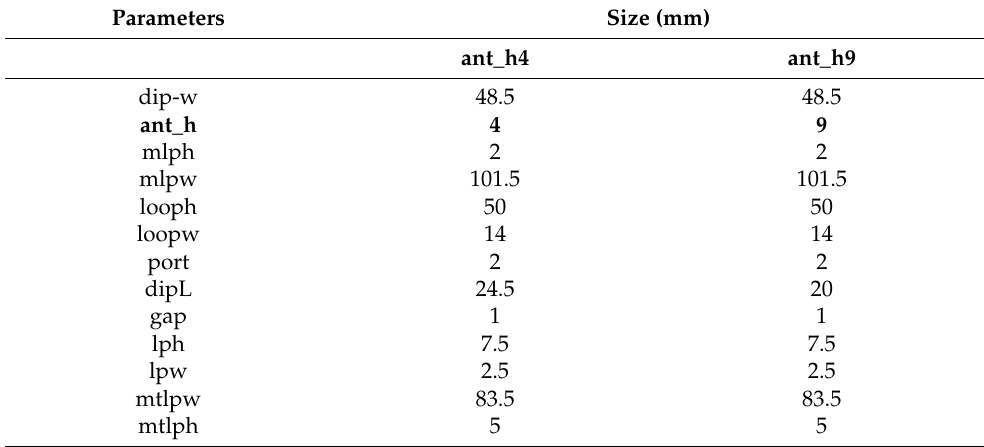
Table 1. Convex tag antenna parameters.